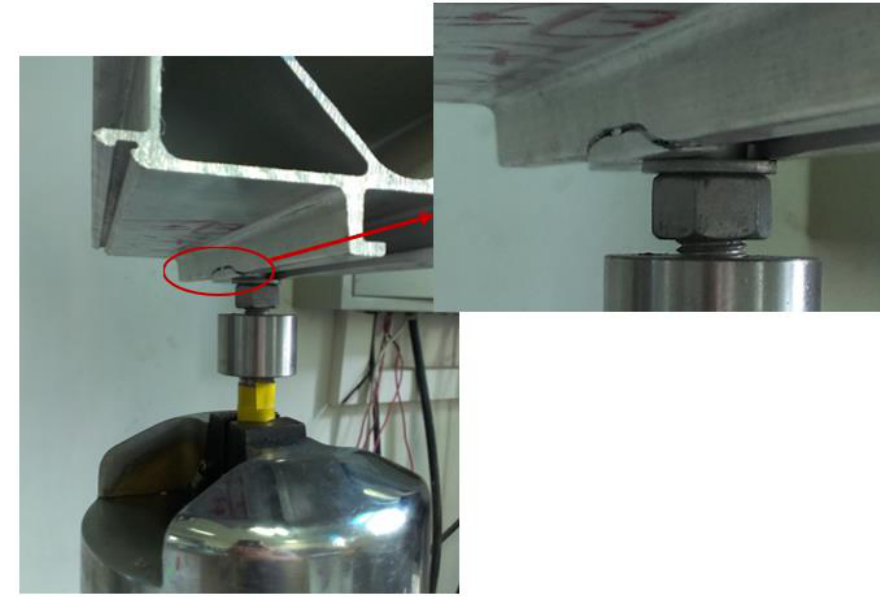
Materials 2023 , 16 , x FOR PEER REVIEW Figure 12. Location of a fatigue fracture in the structural component. Figure 12. Location of a fatigue fracture in the structural component.